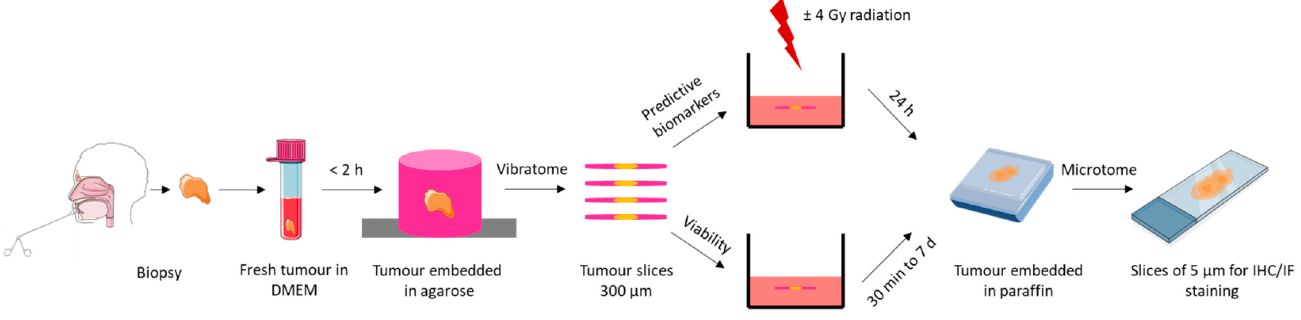
Figure 5. Chronological diagram of biopsy processing.